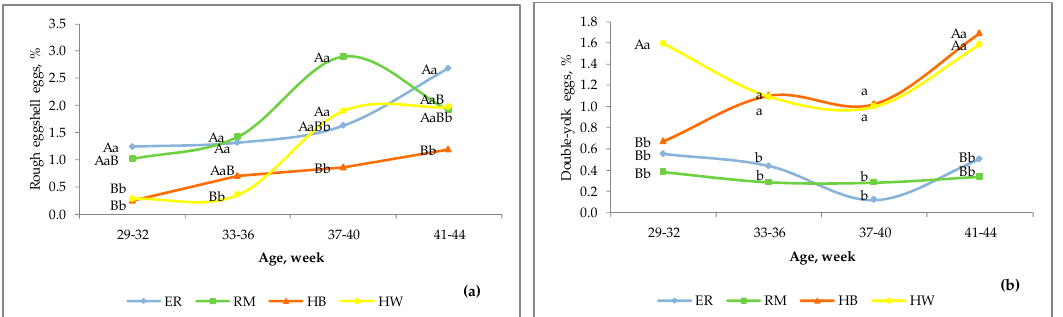
Figure 4. Effect of genotype 1 on rough eggshell eggs (a) and double-yolk eggs (b) according to the age of the hens. Di ff erent letters among lines at each age indicate di ff erent values. a, b, c, d: p < 0.05; A, B, C, D: p < 0.01. 1 Genotype: ER—Ermellinata di Rovigo; RM—Robusta maculata; HB—Hy Line Brown; HW—Hy Line White 36. Observations ( n ) per age (29–32 weeks, 33–36 weeks, 37–40 weeks, 41–44 weeks): ER (1450, 1371, 861, 1192); RM (790, 704, 1070, 892); HB (2083, 2271, 2350, 2188); HW (2138, 2565, 2004, 1833). χ 2 p -value per age: rough eggshell eggs ( < 0.0001, 0.002, 0.0001, 0.22); double-yolk eggs (0.0008, 0.04, 0.009, 0.0008).